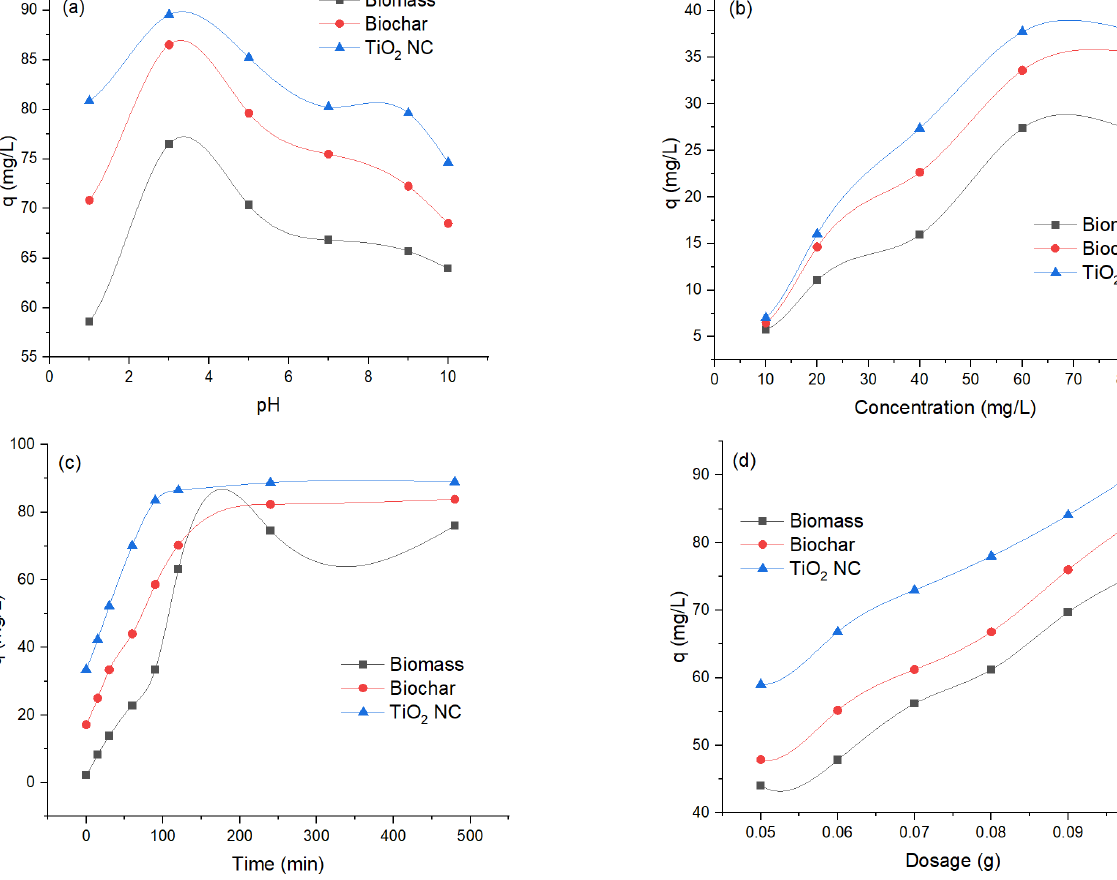
Figure 6. The effect of ( a ) pH; ( b ) concentration; ( c ) contact time; and ( d ) adsorbent dosage for removal of Cr(VI).